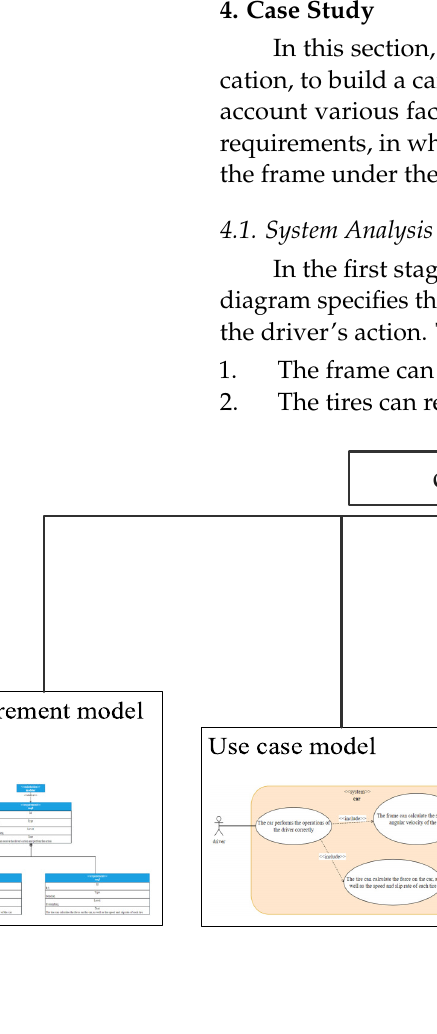
Figure 9. The SES-X Model of The Frame. The tire model has a few requirements, including: 1. The calculation of the vertical load of the wheel, 2.